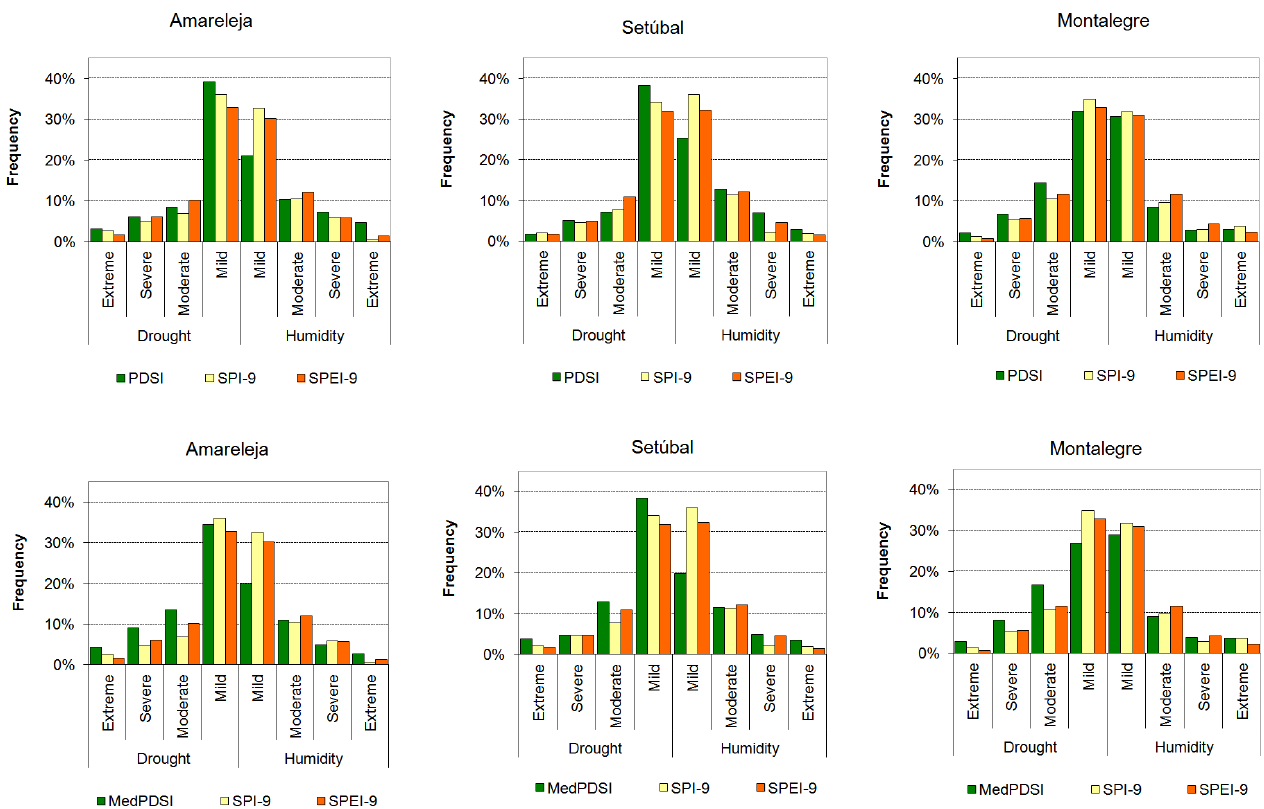
Fig. 4. Frequency of time (%) in each dry or wet category of MedPDSI, PDSI, SPEI-9, and SPI-9 in Amareleja, Set´ubal and Montalegre,